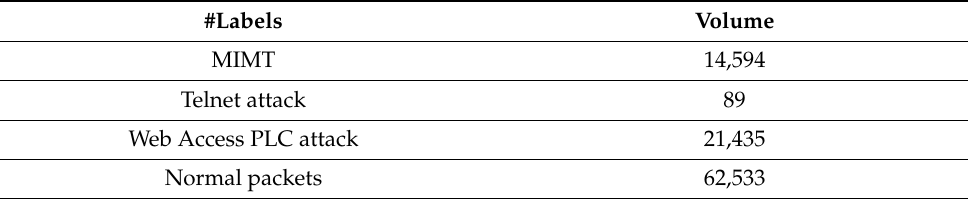
Table 2. Input datasets for each attack